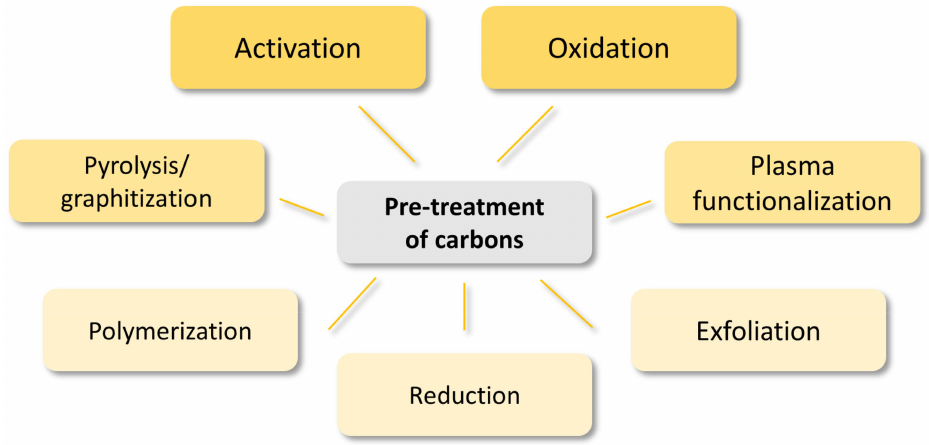
Figure 4. Graphical summary of typical pre-treatment strategies of carbon